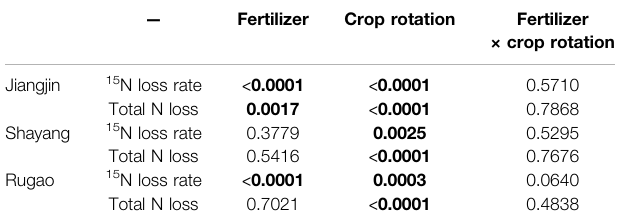
TABLE 5 | ANOVA results ( p values) for the individual effects of interactions of fertilizer (R and T) and crop rotation (RW, RV, and MW) on 15 N loss and total N loss. — Fertilizer Crop rotation Fertilizer